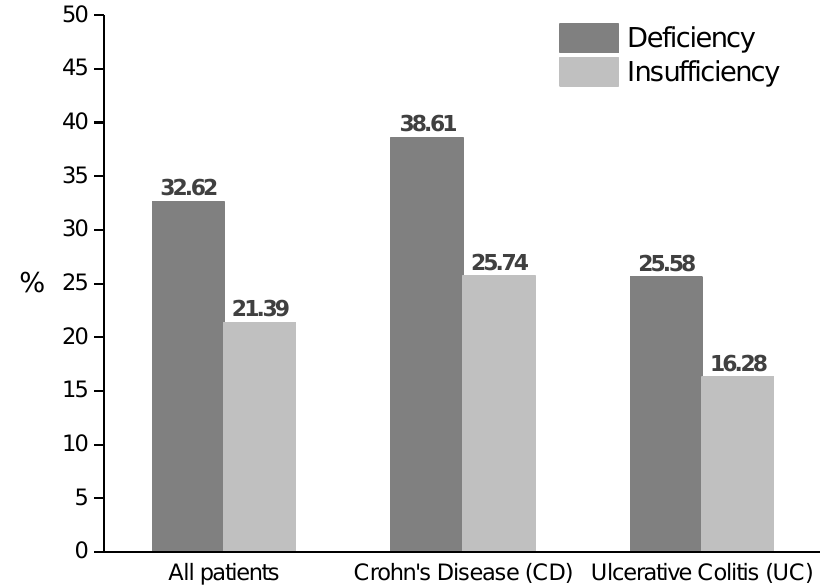
ffi ciency related to total sample ( n =